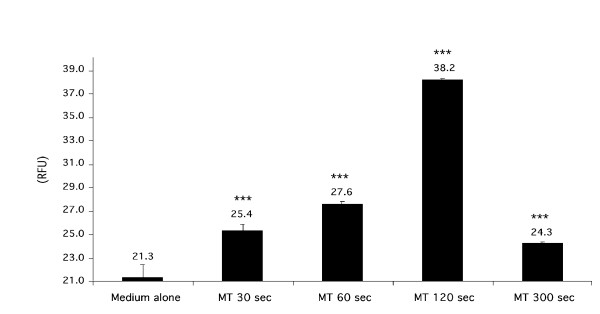
Actin reorganization in metallothionein-stimulated cells. Jurkat T cells were treated with metallothionein at 2 μM and then harvested and fixed at various times after stimulation. Cells were stained with rhodamine phalloidin and F-actin fluorescence quantified using a plate fluorimeter. (RFU = relative fluorescent units). Values reported represent the average of 3 replicates ± standard deviation. *** represents significant difference from the medium alone control (p < 0.001). This data is representative of 3 independent experiments.